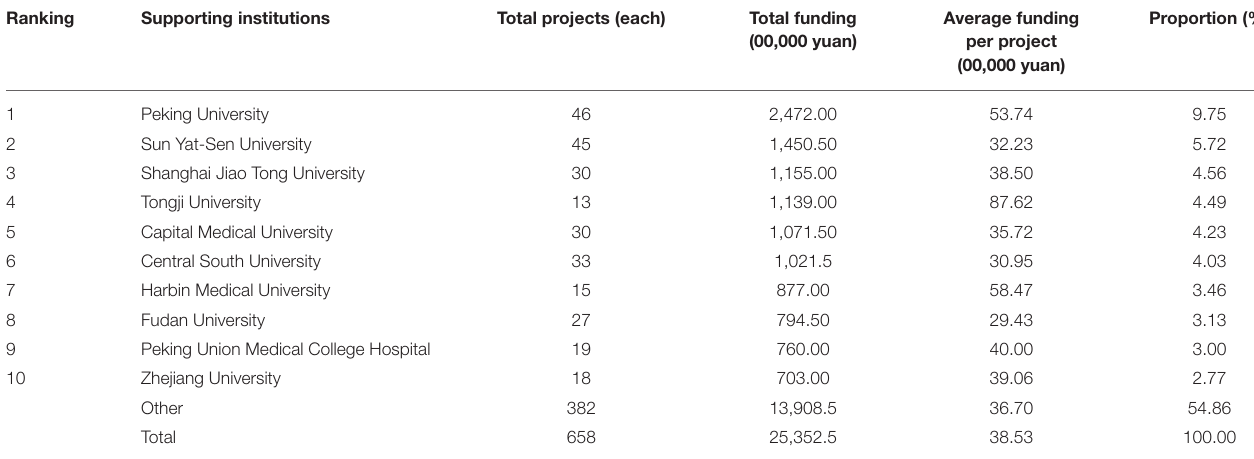
TABLE 6 | Supporting institutions funded by NSFC concerning rare diseases.